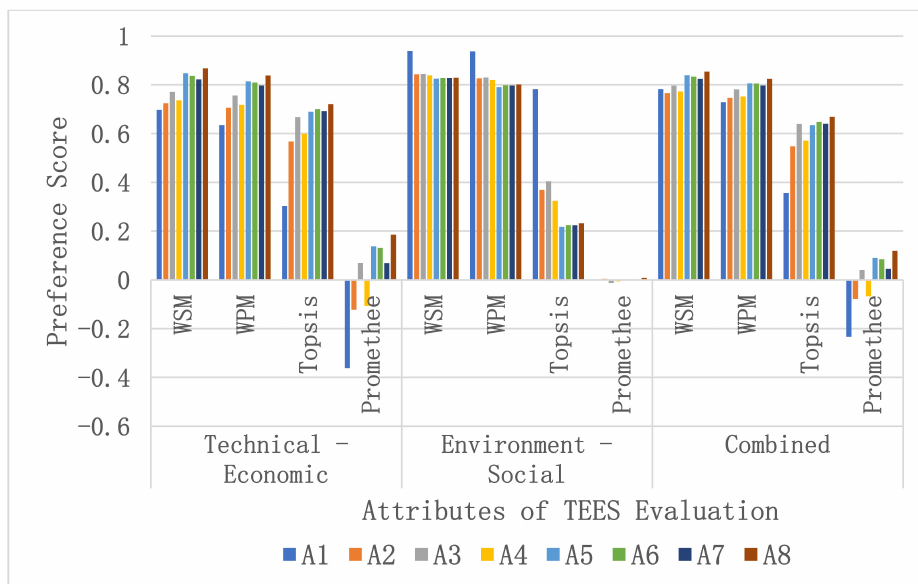
Figure 11. Attributes of TEES evaluation for C1/S4 with DGs only at LG2 at 0.9